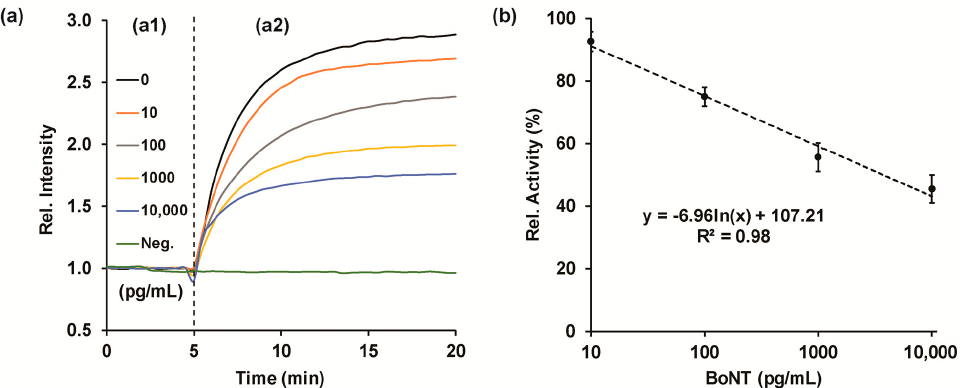
Figure 3. Biosensing system optical response toward BoNT-C toxoid different concentrations. ( a ) Representative relative intensity changes vs. time of the HRP catalytic response for the different target analyte concentrations (0 − 10,000 pg mL − 1 ). Negative control omitting the addition of pAb to the protocol assay. Note: all sensorgrams present optical baselines with 0.8 mM 4CN in HEPES buffer ( a1 ) followed by the addition of H 2 O 2 to the cycled solution ( a2 ). The biosensor is fixed in a custom-made flow cell, and the reflectivity spectra are recorded every 30 s. ( b ) The corresponding calibration curve of the relative activity for the different toxoid concentrations. Data are reported as mean ± SD ( n = 4).